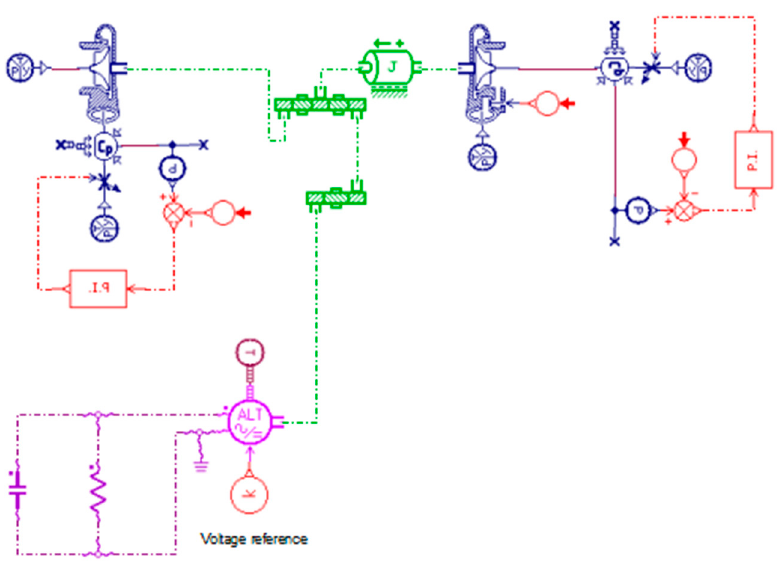
Figure 4. Overview of hybrid turbocharger components with AMESim software.